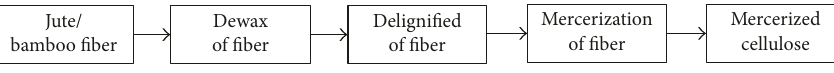
Figure 1: Flow diagram of cellulose